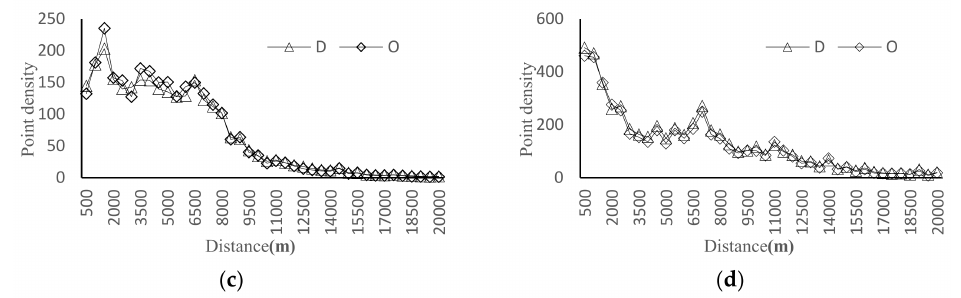
Figure 8. Spatial distribution of the traffic attraction of the four functional regions: ( a ) Taxi O/D points’ attraction for ZGC; ( b ) taxi O/D points’ attraction of WJ. The O/D point density curve of WJ shows three peaks at 4 km, 9.5 km and 12.5 km, which coincide with the distances between WJ and the other three functional regions; ( c ) Taxi O/D points’ attraction for XD. The O/D point density curve of XD gradually decreases to zero at 10 km, indicating that the residents’ average trip distance by taxi is 10 km and generally not more than 20 km; ( d ) Taxi O/D points’ attraction for GM.